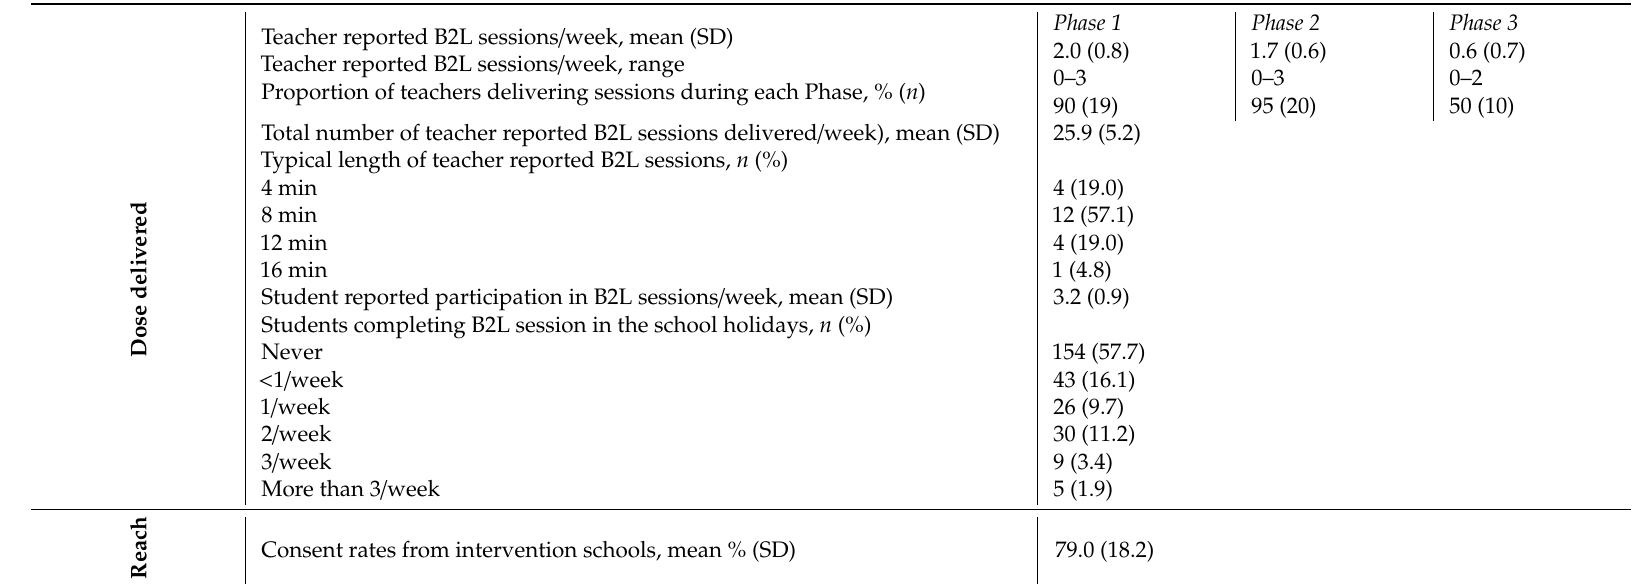
Table 3. Findings for the included implementation